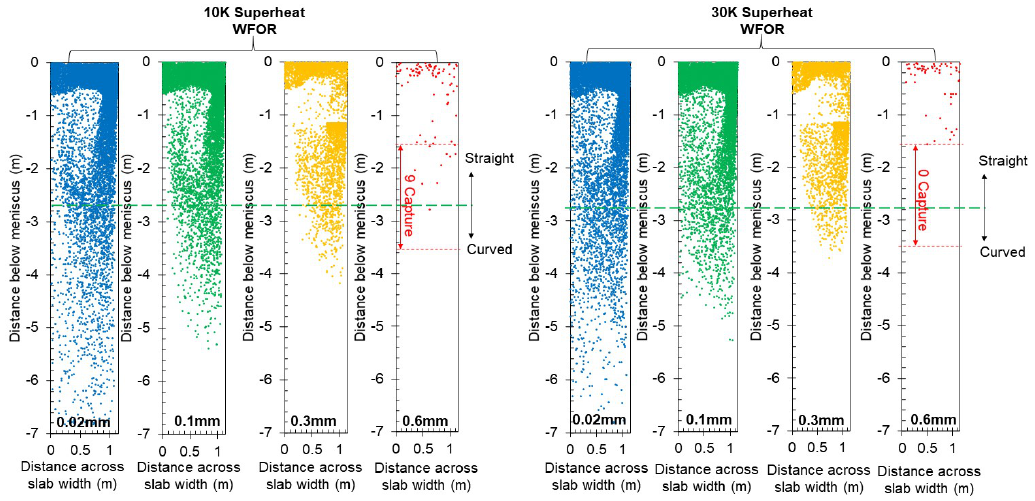
Figure 20. Capture locations on the wide face outer radius (WFOR) for selected bubble sizes—front view.